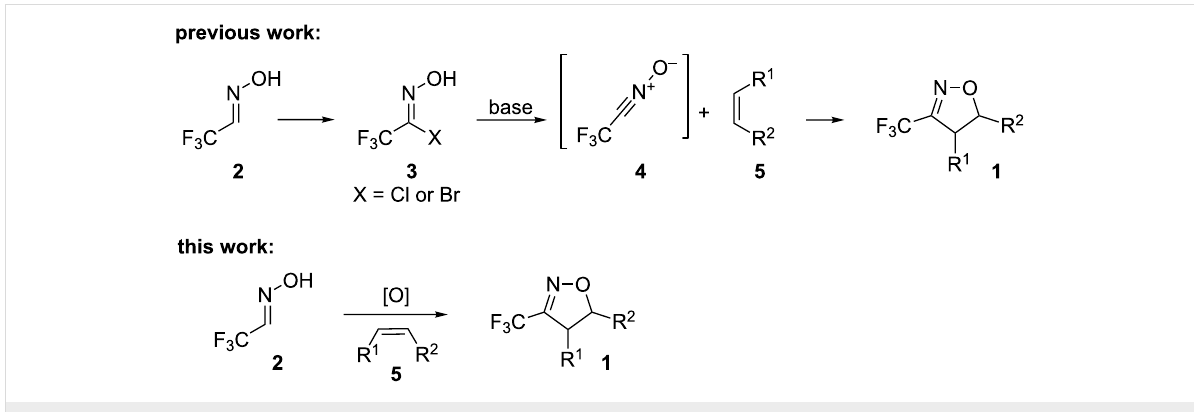
Scheme 1: Synthesis of